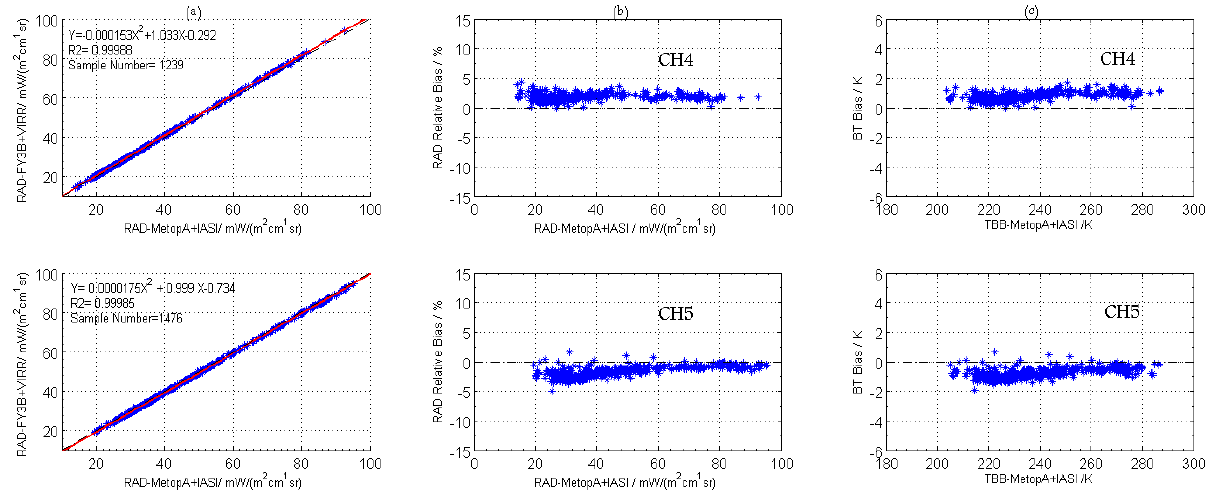
Figure 8. Radiance comparison between FY-3B/VIRR and METOP-A/IASI ( a ); as well as their observation differences (VIRR-IASI) in radiance ( b ) and BT ( c ) using collocation samples in August 2012. The red lines are quadratic fitting results. The top plots are for CH4, and those on the bottom are for